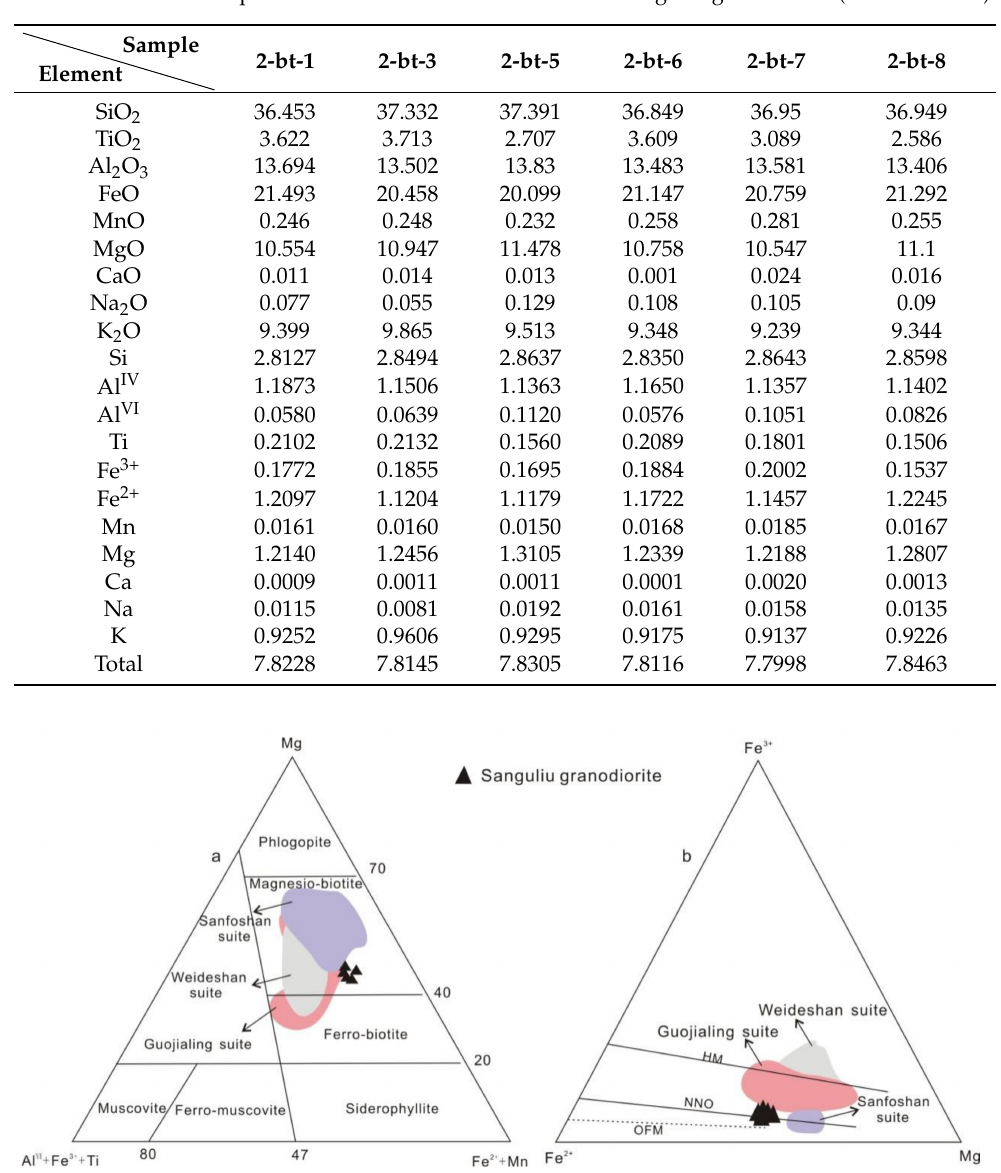
Table 7. Electron microprobe data of the biotites from the host Sanguliu granodiorite (results in wt%).